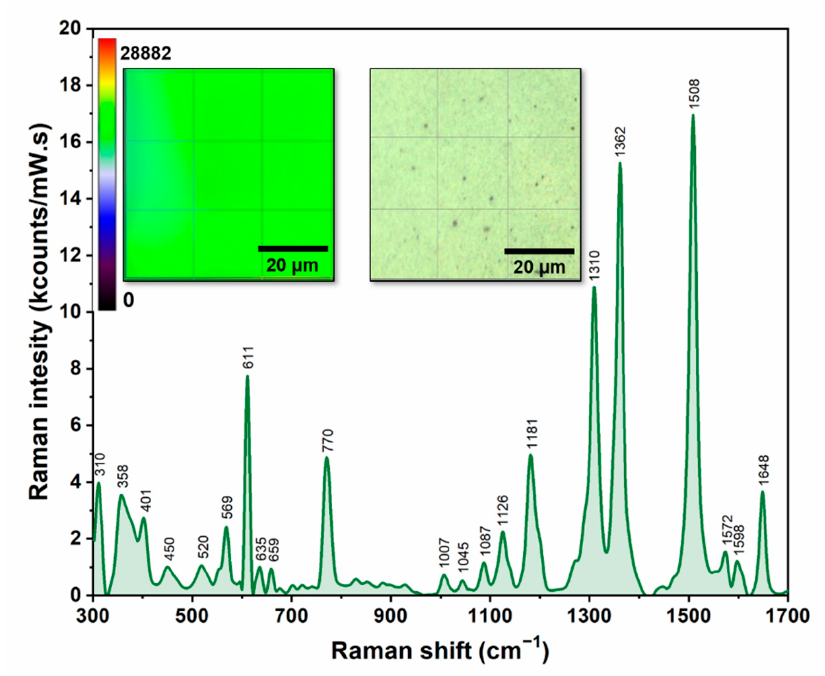
Figure 3. SER spectrum of R6G analyte recorded by using a 785 nm laser. The left inset shows the heat map created by using the intensity of the 1508 cm − 1 band. The right inset presents a 60 × 60 µm 2 optical image of the substrate.